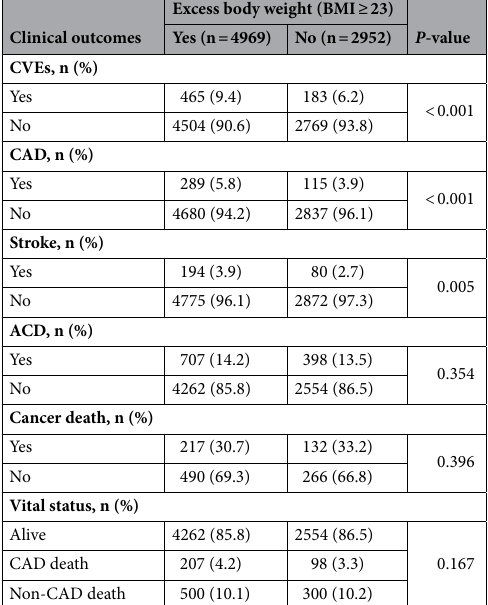
Table 2. Long-term clinical outcomes evaluated at the end of follow-up. ACD all-cause death, CAD coronary artery disease, CVEs cardiovascular